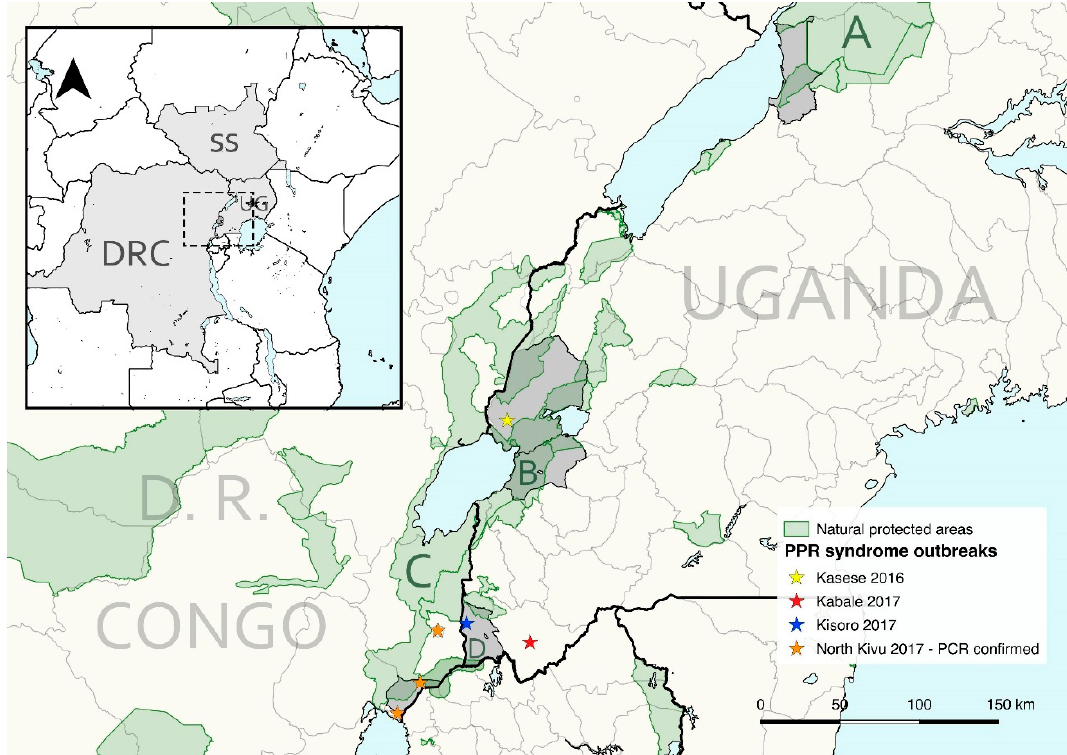
Figure 1. General map of East Africa (left upper corner) highlighting the countries included in this study: South Sudan (SS), Uganda (UG), and Democratic Republic of the Congo (DRC). The northern area of the Albertine Rift is magnified showing, shaded in grey, the administrative subdivisions of Uganda and DRC where livestock sampling was performed (from north to south: Buliisa district, Kasese district, Rubirizi district, Kisoro District, and Nyiragongo territory in North Kivu) and PPR-like outbreaks recorded in small livestock 2015–2017 reported in this study. The transboundary Greater Virunga Landscape includes the study areas of Queen Elizabeth National Park (B) and Mgahinga Gorilla National Park (D) in Uganda, and Virunga National Park in DRC (C). Murchison Falls Conservation Area is highlighted